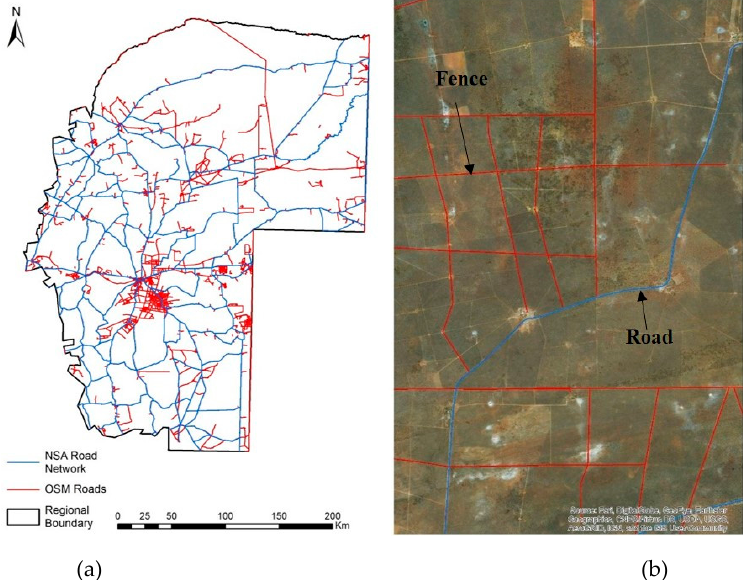
Figure 12. ( a ) Comparison of OpenStreetMap to Namibia Official Roads, ( b ) zoom on one area showing OSM road as fence.